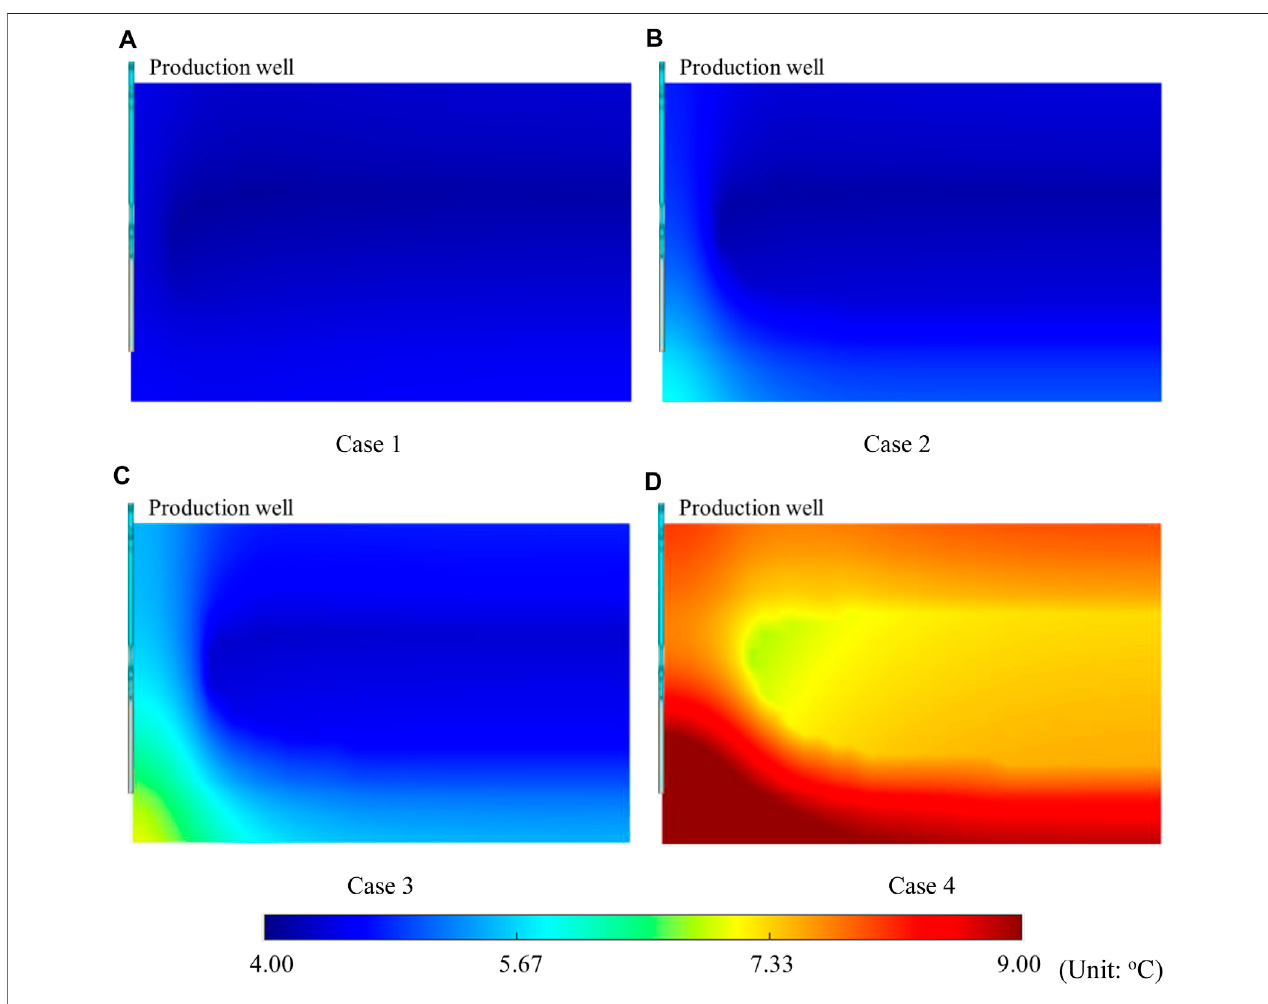
FIGURE 10 | Temperature distribution of each case. (A) Case 1. (B) Case 2. (C) Case 3. (D) Case 4.